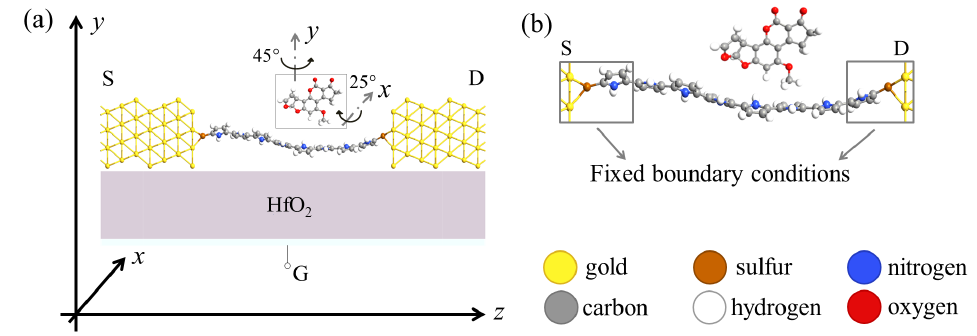
Figure 5. ( a ) Pictorial representation of the adsorption study strategy. ( b ) Example of a simulated adsorption geometry. The figure highlights the atoms which were kept fixed during the adsorption study to emulate fixed boundary